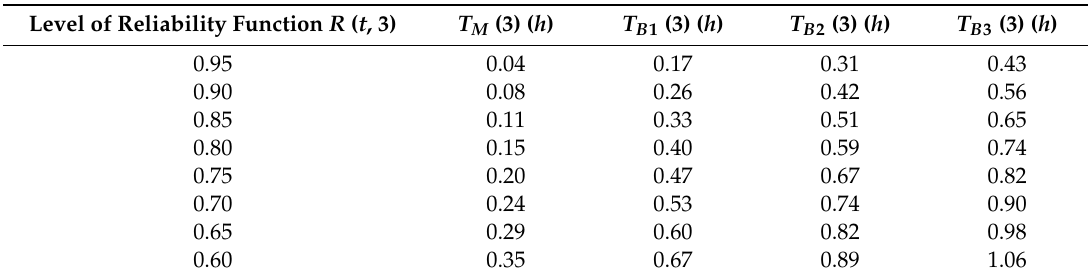
Table 3. Comparison of moments of exceeding the level of reliability function coordinate R ( t , 3) for di ff erent system configurations depending on the number of back-up systems. Level of Reliability Function R ( t ,